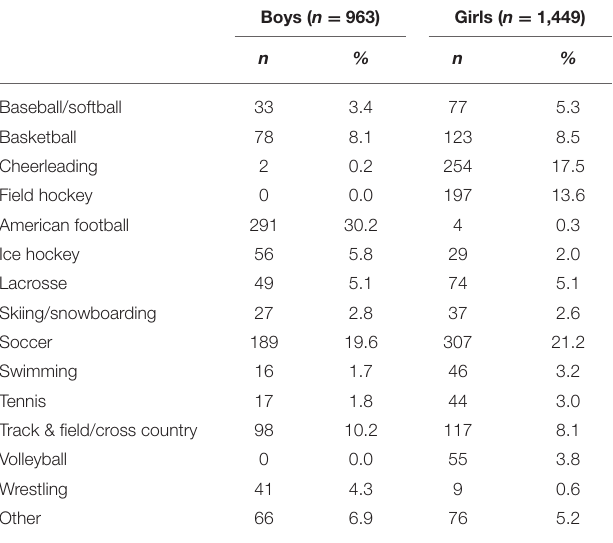
TABLE 2 | Primary sport affiliation by